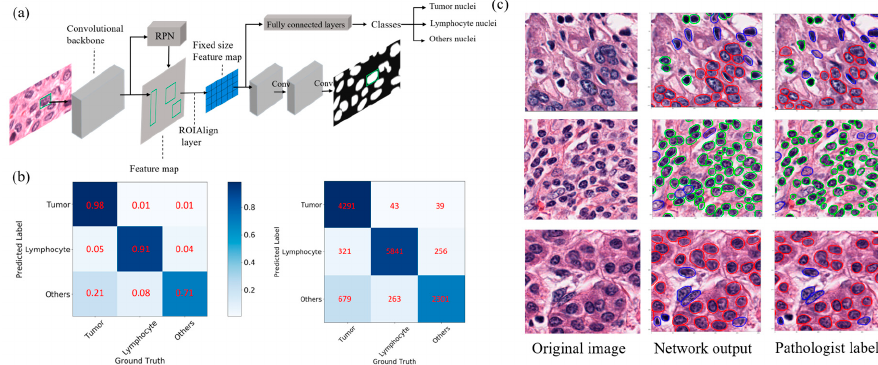
Figure 1. Proposed deep learning scheme for automated nuclei segmentation and classification based on Mask R-CNN ( a ). The confusion matrices for cell-type classification are shown for the testing dataset ( b ). Values are the percentage and number of nuclei correctly (diagonal) and incorrectly (off-diagonal) classified by the algorithm. Visual representation of nuclei segmentation and classification for some examples are shown in ( c ). The magnification for all images is 40×. Red, green, blue outlines for individual nuclei correspond to those of tumor cells, lymphocytes, and other cells, respectively. RPN: region proposal